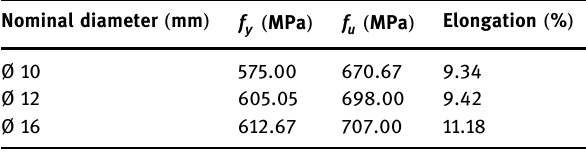
Table 2: Mechanical properties of steel